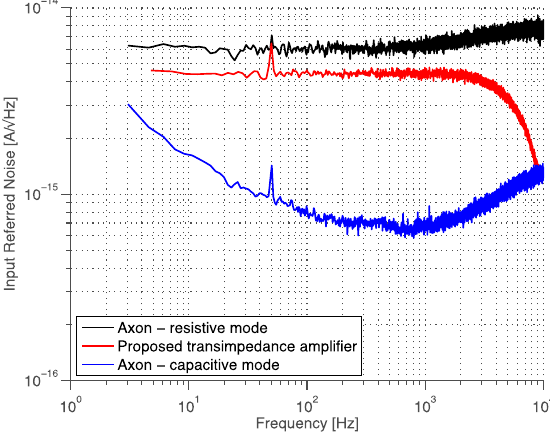
Figure 15. Input-referred noise compared with benchmark instrument for biological current acquisition. The peaks shown in all the lines are due to spurious coupling from the 50 Hz